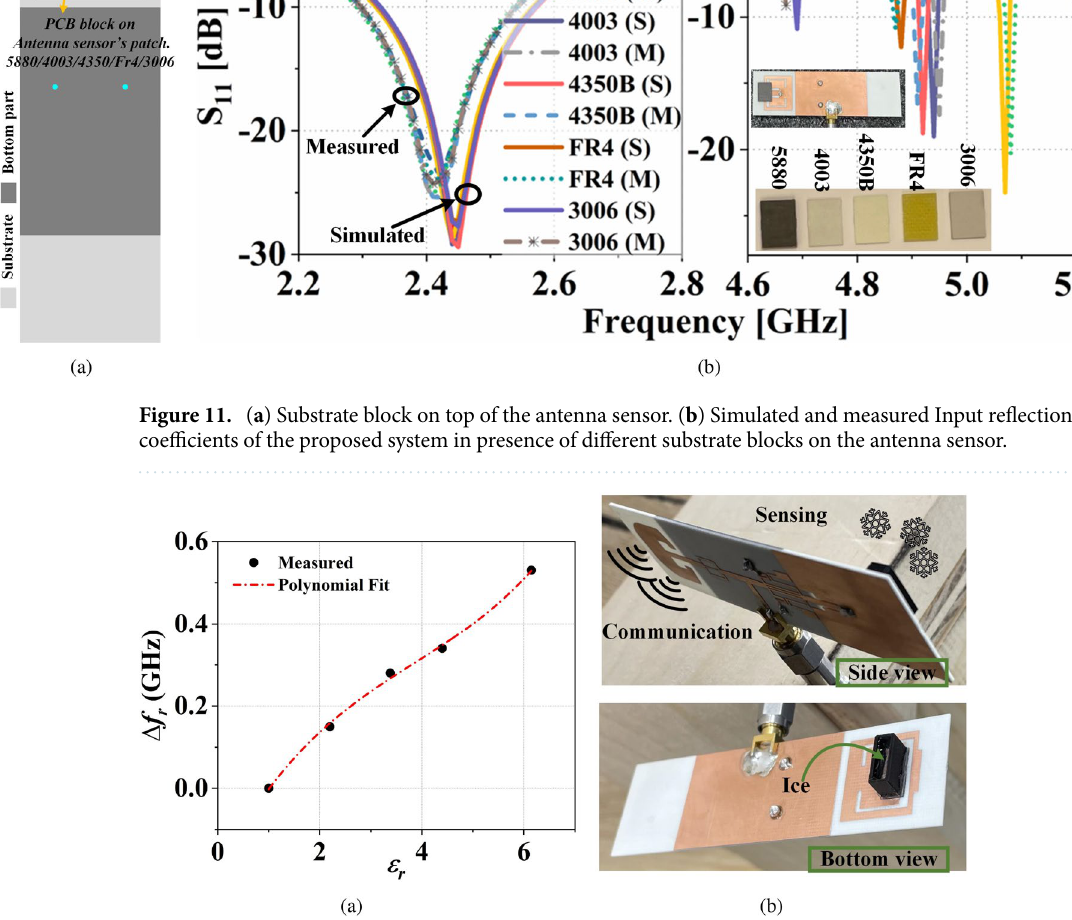
Figure 12. ( a ) The measured and polynomial fit of the resonance frequency shifts of the antenna sensor with respect to the permittivity of the MUTs. ( b ) Sensing and communication plane of the dual-functional antenna